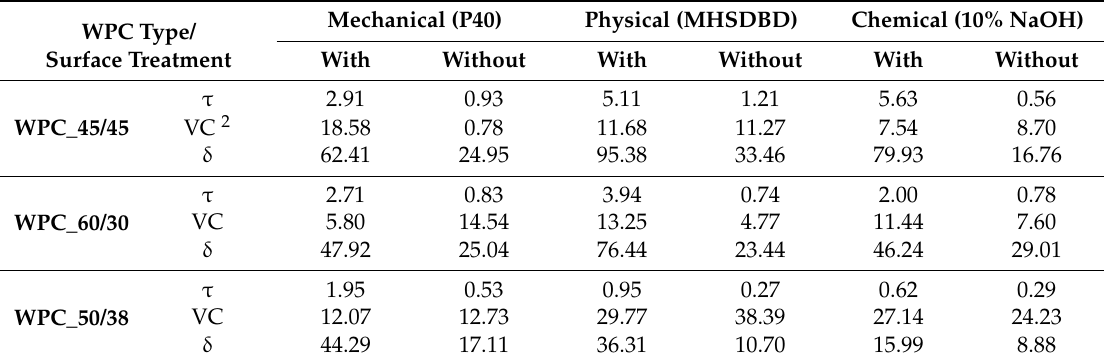
Table 5. Average shear stress τ (in MPa), variation coefficient (in %) and tensibility (in %) of samples WITH and WITHOUT primer 1 .